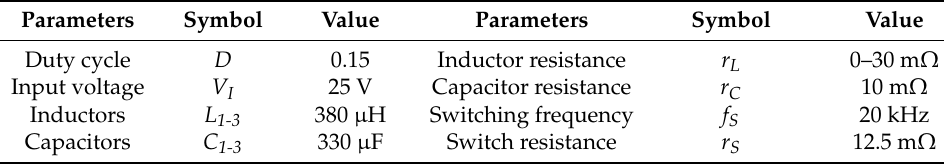
Figure 15. ( a ) Gate signals, ( b ) input and output voltages, and ( c ) voltages across capacitors C 1 and C 2 . Table 4. Simulations and experimental